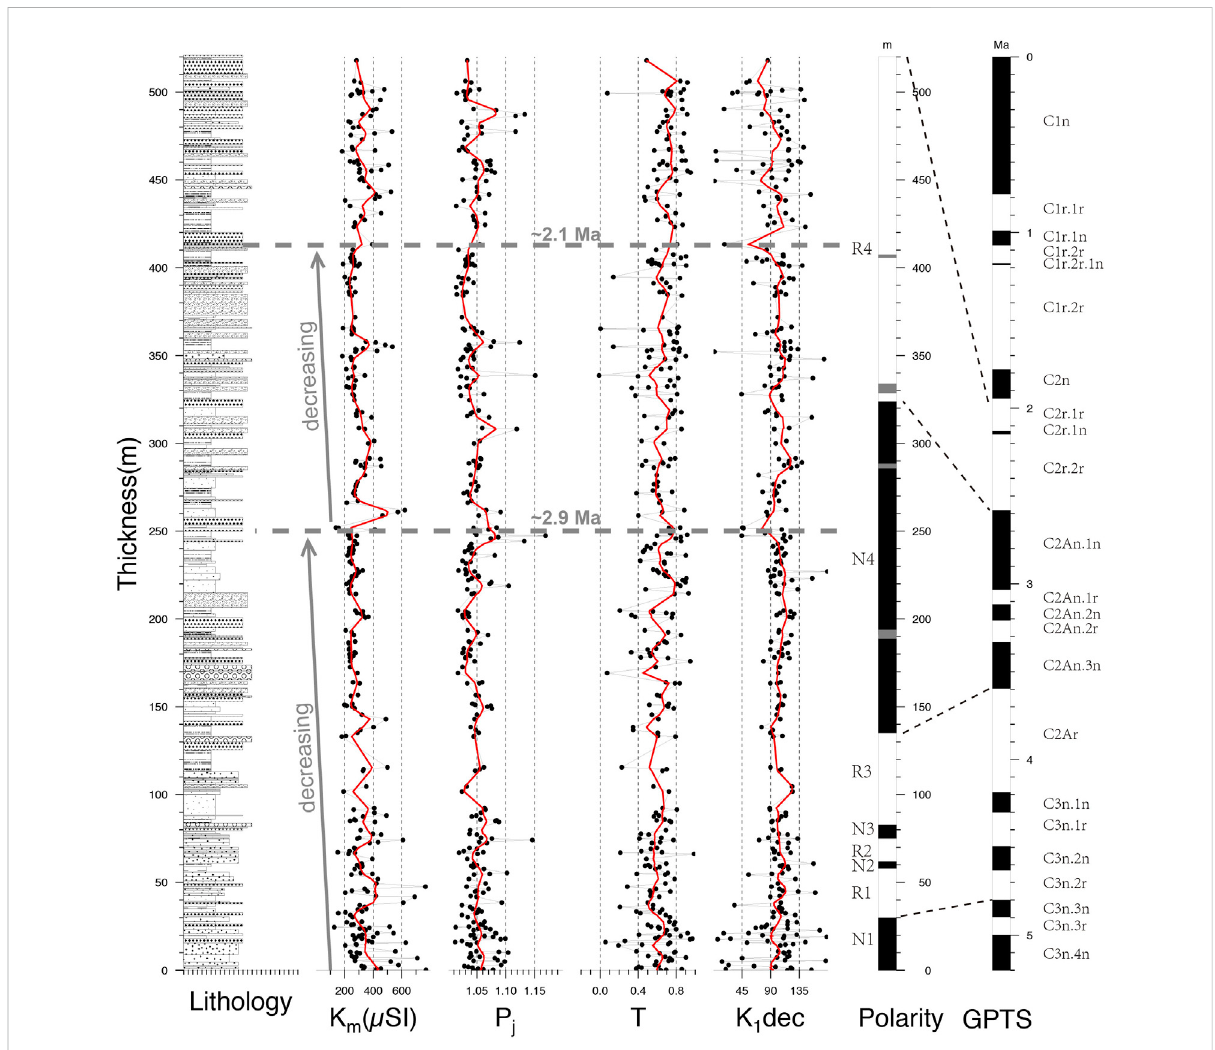
FIGURE 9 Magneticsusceptibility(K m ),theDegreeofAnisotropy(P j ),theShapeParameter(T)andthedirectionofthemaximumsusceptibilityaxes(K 1 )asa function of depth in the Yengisar section. The red curves are obtained by data fi ltering, weights are given by Gaussian function with 20 m intervals in stratigraphic